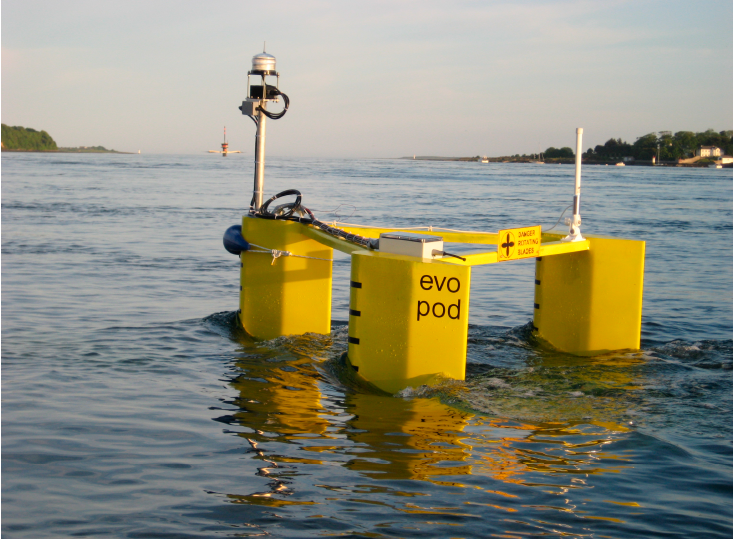
Figure 3. The prototype Evopod semi-submerged tidal energy device. (Source: A Picture of Evopod installed in Strangford Lough near Portaferry, Northern Ireland, by Ocean Flow Energy Ltd, retrieved from https://commons.wikimedia.org/wiki/File:Evopod_in_Strangford_Lough_2008.jpg).